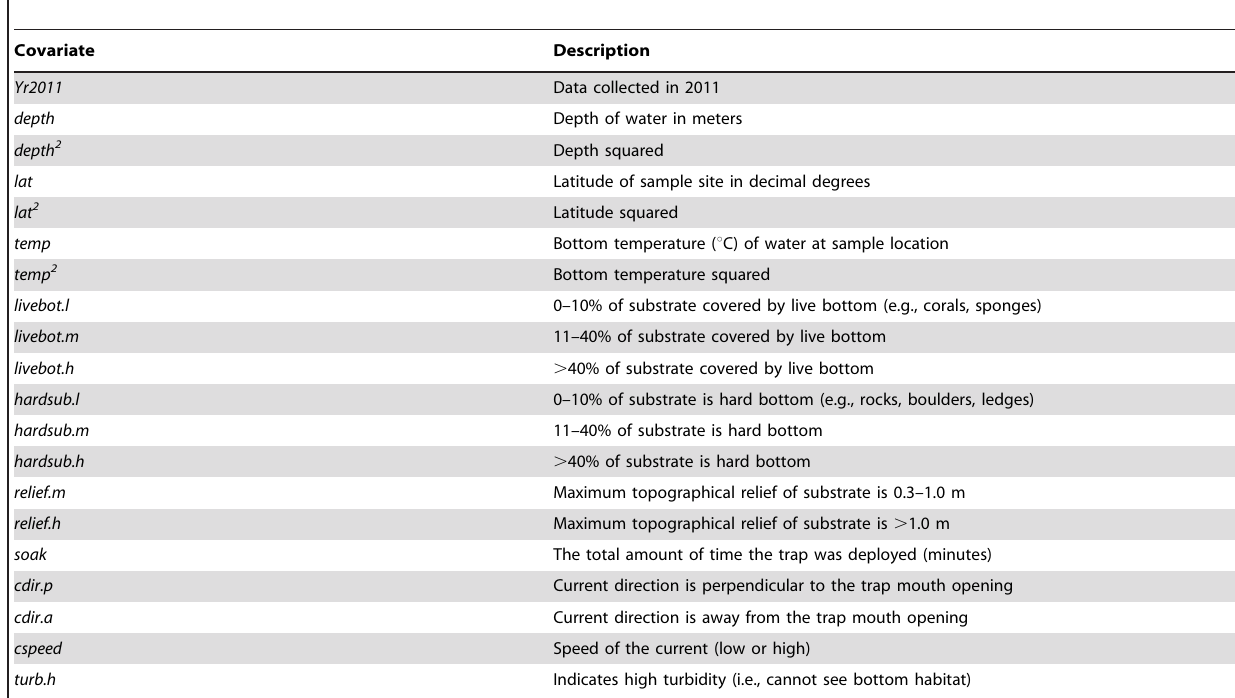
Table 1. Variables evaluated as potential covariates influencing patterns in occurrence, abundance, and/or detection of red snapper Lutjanus campechanus